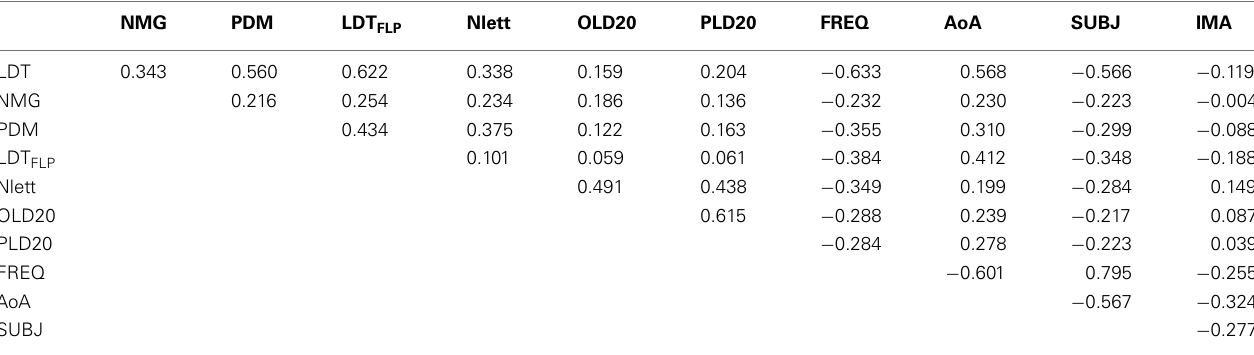
Table 3 | Correlations between the various measures (correlations lower than r =− 0.051 or higher than r =+ 0.051 are significant at p < 0.05, N =